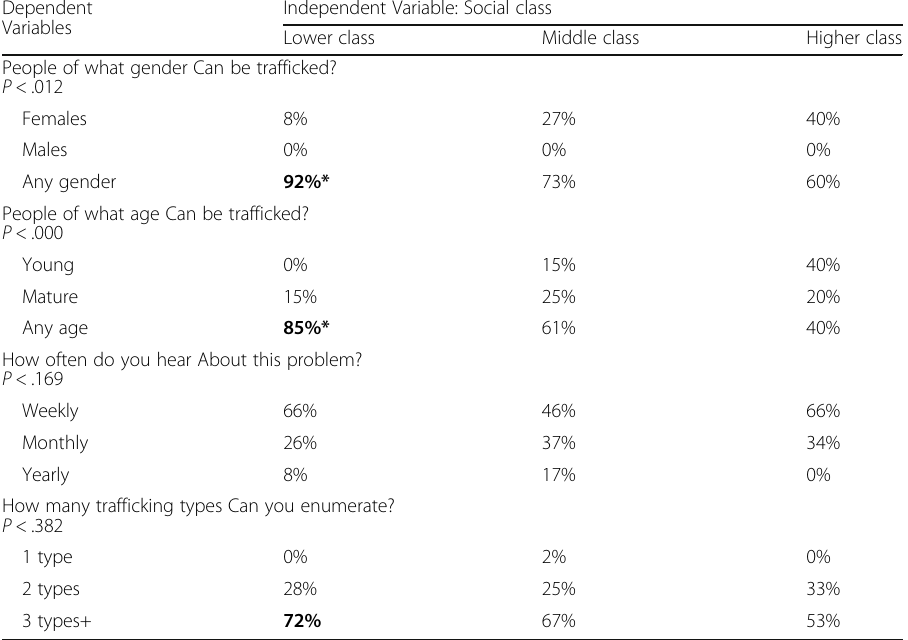
Table 3 Social class and knowledge about human trafficking Dependent Independent Variable: Social class Variables Lower class Middle class Higher class People of what gender Can be trafficked? P < .012